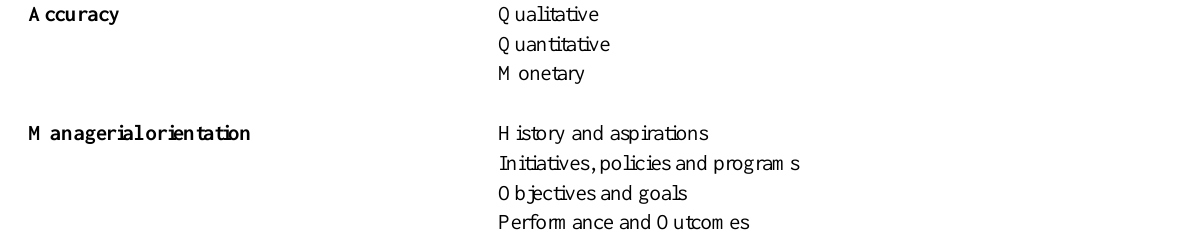
Table 4 : Semantic properties classification